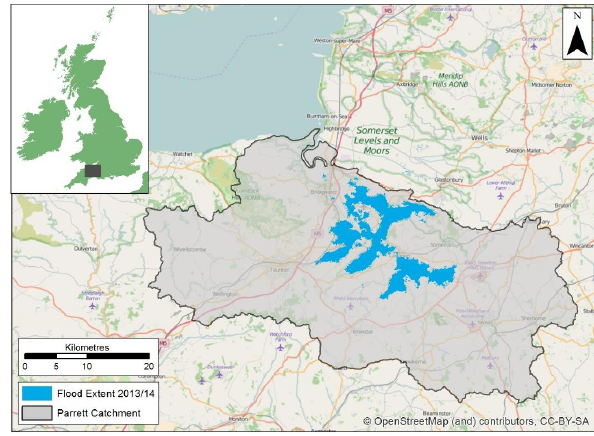
Figure 1. The location of the Parrett catchment, within the Som- erset Levels area of south-western UK. The extent of the flooding in 2013/2014 is also